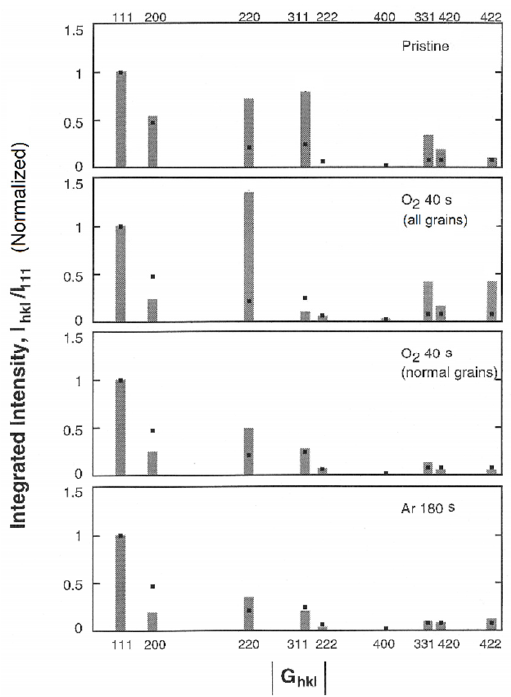
Figure 4. Summary of diffraction intensities obtained from selected-area TEM diffraction patterns of Al films. The intensities of random grains (JCPDS) were indicated by symbol ■ .